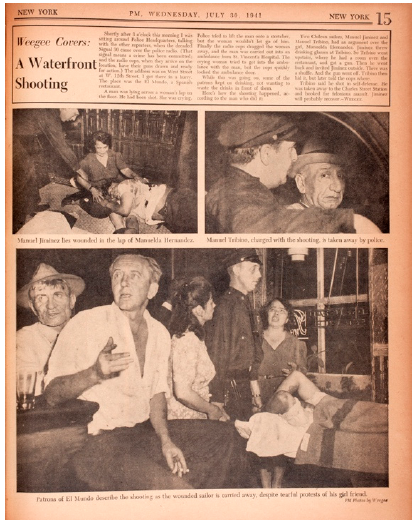
Figure 10. Weegee, “Weegee Covers: A Waterfront Shooting”, PM , 30 July 1941. Image courtesy